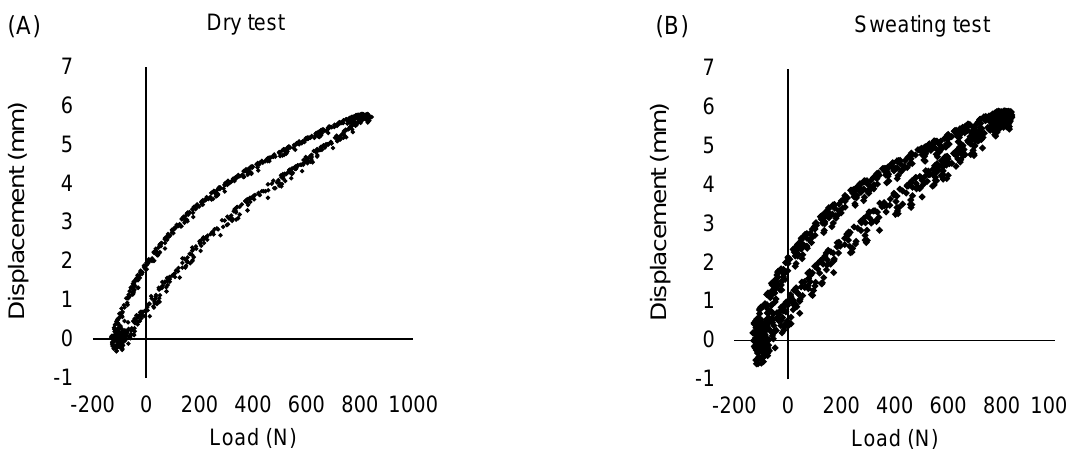
Figure 3: (A) The hysteresis curve of a dry test with the standard liner (B) the hysteresis curve of a ‘sweating’ test with the standard